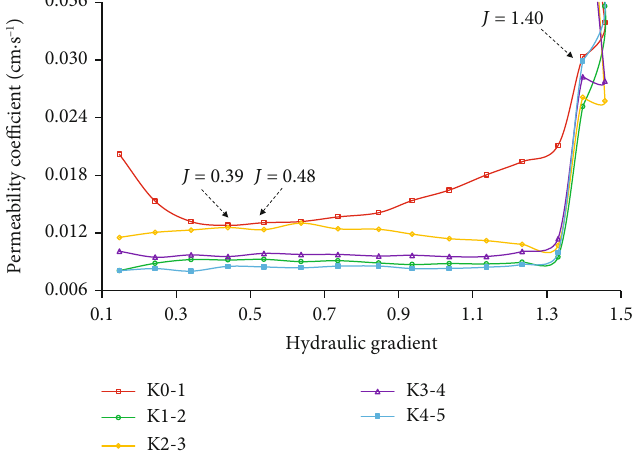
Figure 7: Process curve between hydraulic gradient and permeability of di ff erent parts in soil numbered